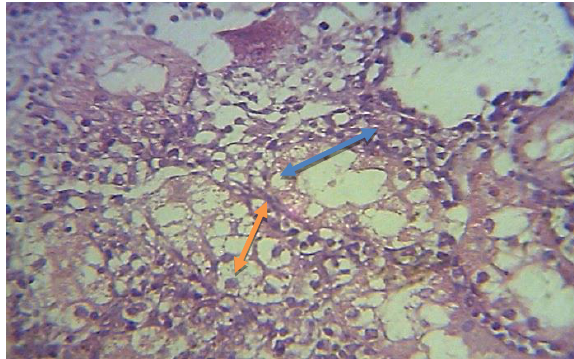
Fig. 3: Kidney of T1 group at 42-day post treated shows severe acute cellular degeneration with mononuclear cells infiltration between renal tubules and proliferation of fibrous connecive tissue between necrosis renal tubules (H and E stain 40x).